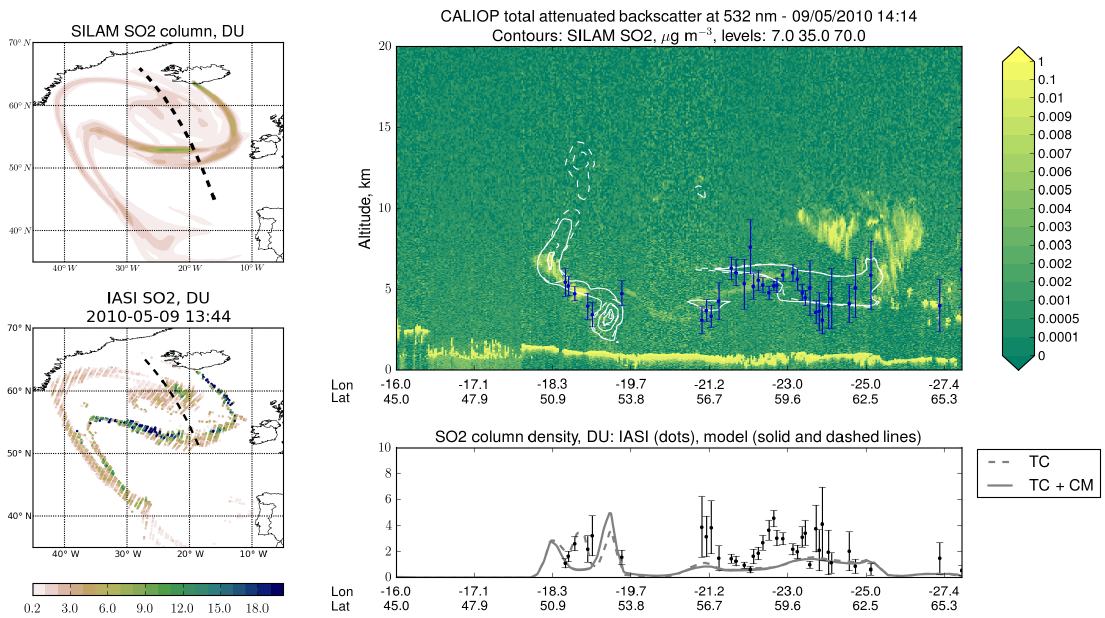
Figure 13. The same as Fig. 12 but for 9 May